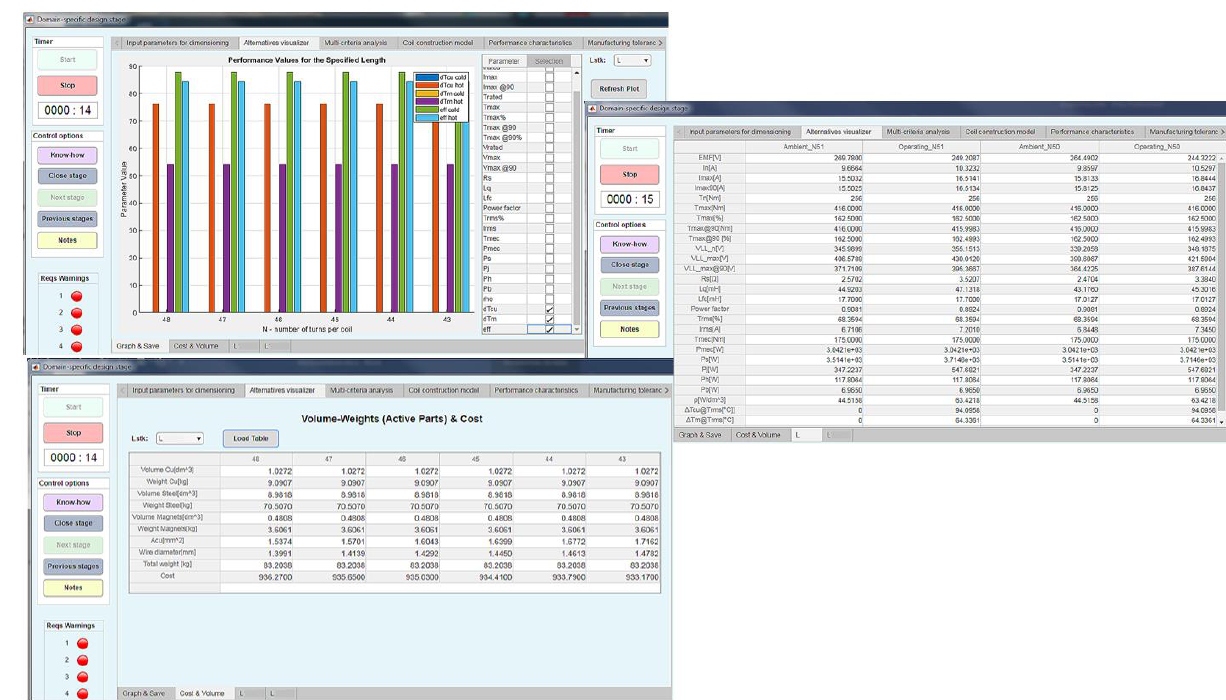
Figure 15. Tools to analyze and visualize the solution alternatives.